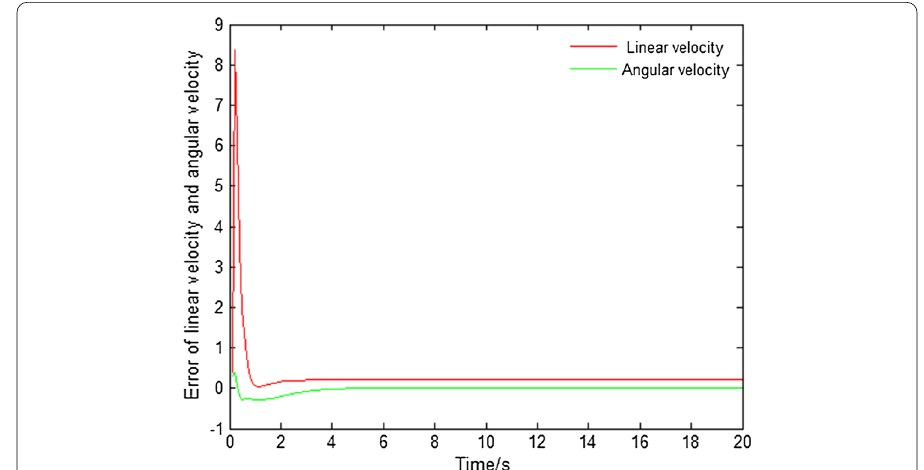
Fig. 5 Linear velocity and angular velocity diagram of linear trajectory